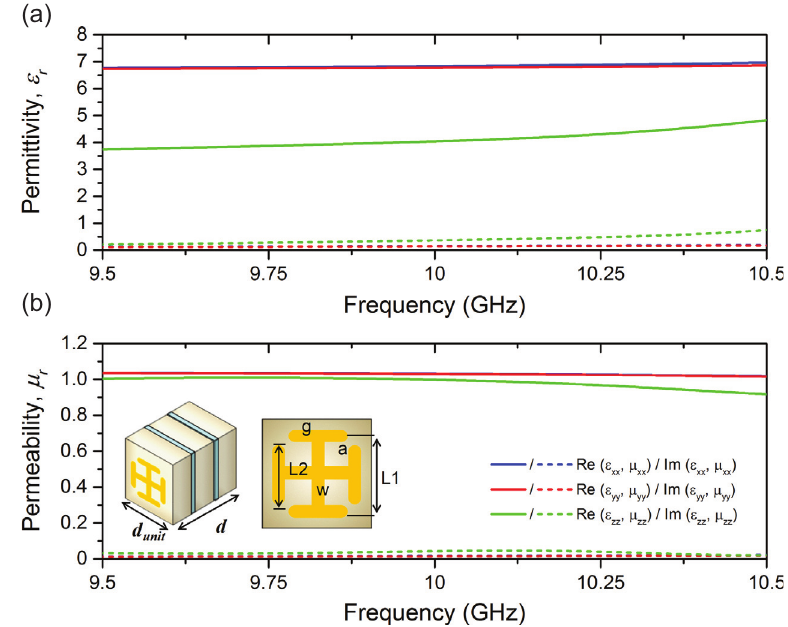
Figure 9. Retrieved permittivity (a) and permeability (b) of the simulated WAIM. Inset: Side and front view of metamaterial unit cell: d unit = 2 mm, d = 4.812 mm, L 1 = 1.6 mm, L 2 = 1.1 mm, a = 0.1 mm, g = 0.2 mm and w = 0.2